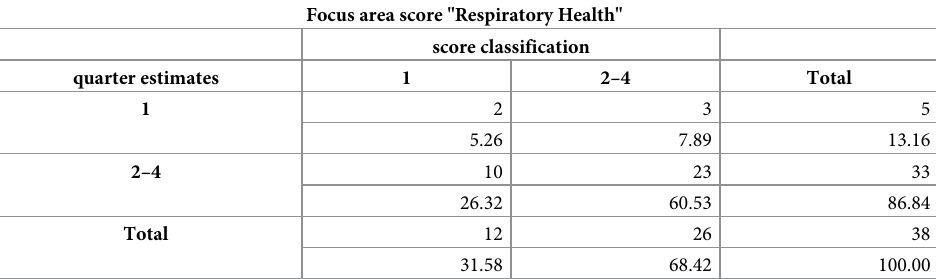
Table 7. Contingency table for the dichotomous division of the score "Respiratory Health" (first number frequen- cies, second number